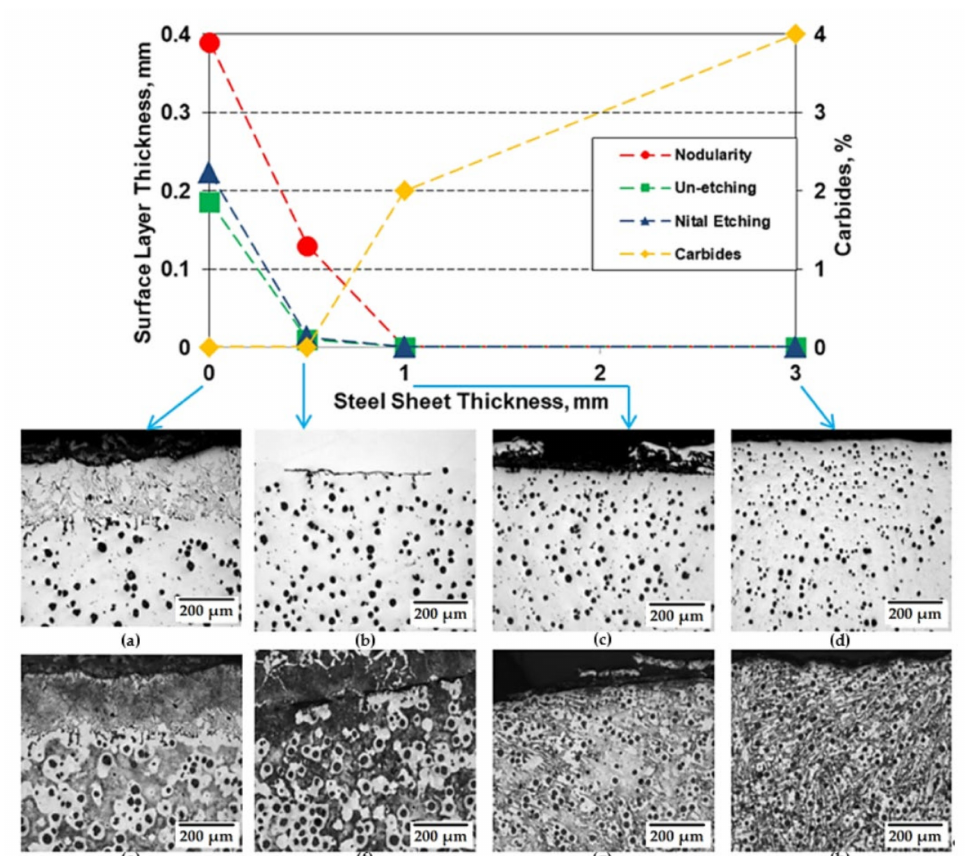
Figure 4. Graphite degenerated layer thickness as steel sheet thickness influence in un-etching and Nital etching conditions, respectively. Superficial layer structure as reference ( a , e ), 0.5 mm steel sheet influence ( b , f ), 1 mm steel sheet influence ( c , g ) and 3 mm steel sheet influence respectively; a , b , c , d -un-etched samples; e , f , g , h -Nital etched